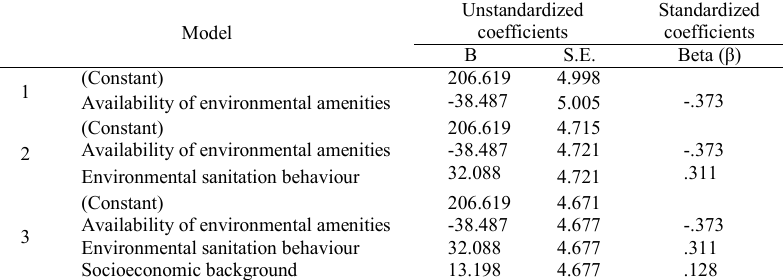
Table 3: Regression coefficient summary